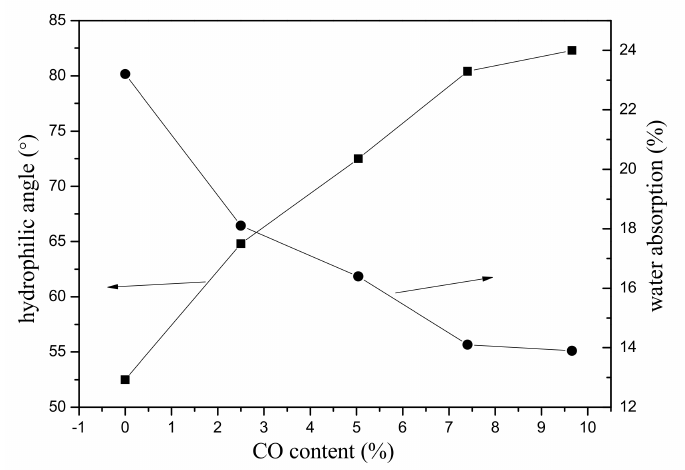
Figure 9. Hydrophilic angle and water absorption of WPU films as a function of TMPM